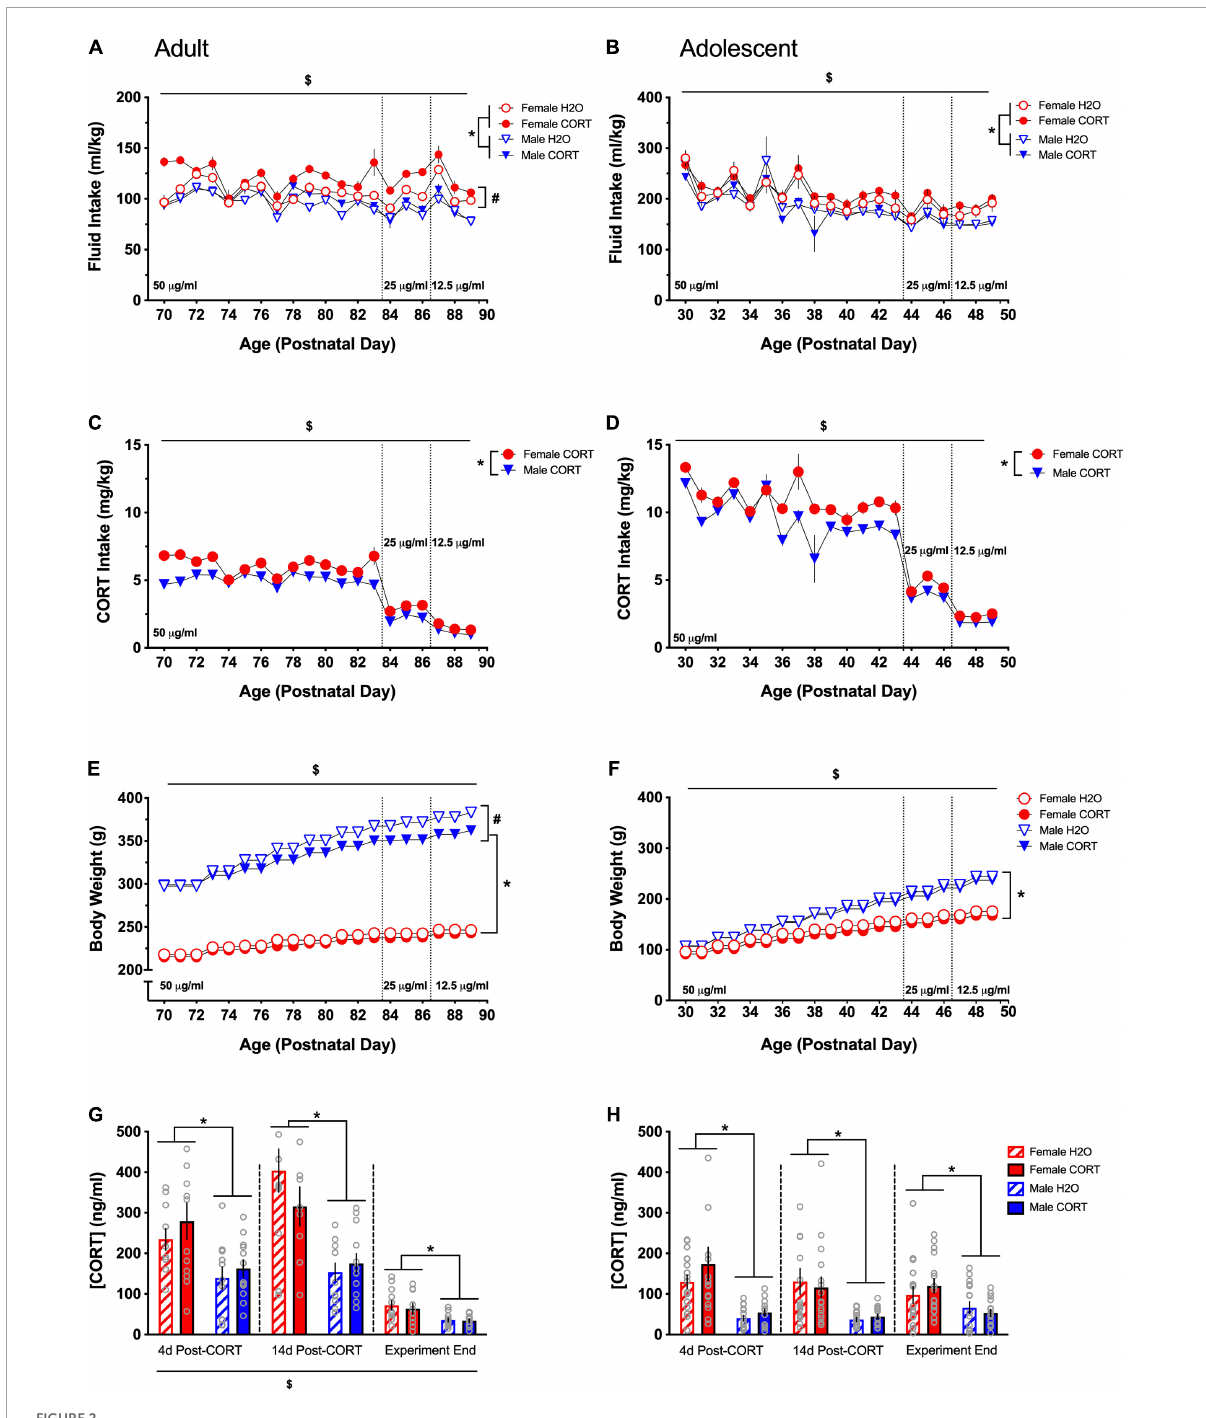
FIGURE2 Females exhibit higher consumption of and plasma levels of CORT than males regardless of age. Both adult- (A) and adolescent-exposed (B) female and CORT-treated rats drank more fluid relative to their body weight (ml/kg) compared to male and H 2 O-treated rats, respectively. Total CORT (mg/kg) intake decreased with titration of the solution concentration, and females received higher doses of CORT than males in both adult (C) and adolescent-exposed (D) rats. Male rats weighed more than females and gained more weight over time in both adulthood (E) and adolescence (F) . In adulthood only, CORT treatment reduced body weight in males (E) . Adult CORT-treated males weighed significantly, but marginally less than H 2 O-treated controls. Females had higher plasma CORT levels compared to males in adult (G) and adolescent (H) treated rats at each time point. * p < 0.005 (male vs. female); # p < 0.05 (H 2 O vs. CORT); $ p < 0.05 (main effect of